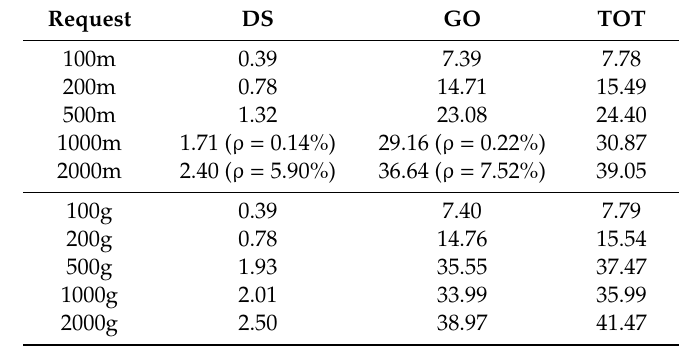
Table 16. Requests per second (total and for different SOS request) with different concurrent data consumers and WSGI applications for the test case of a large size monitoring network (case C) excluding the getObservation request. Rate of failure (ρ) is reported when errors have been detected.